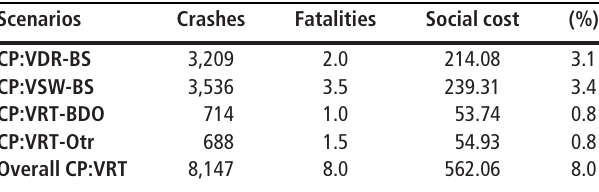
Table VIII Crashes, fatalities and social cost of CP:VRT